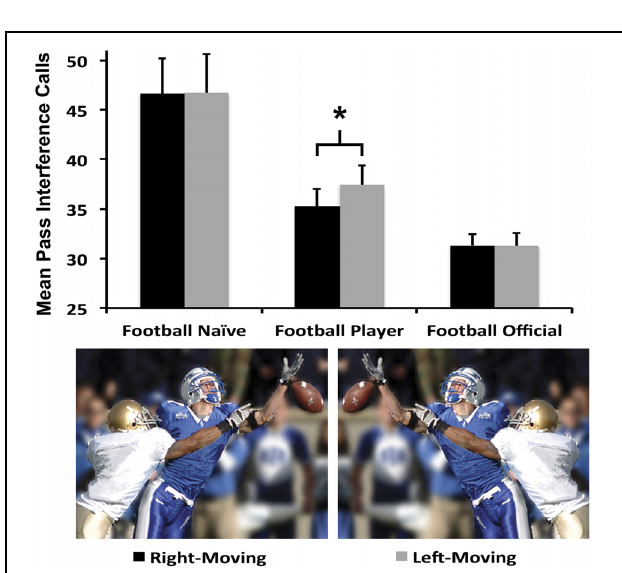
FIGURE 2 | Average number of right-moving versus left-moving pass interference calls for each group with two example stimuli. ∗ p < 0.05.